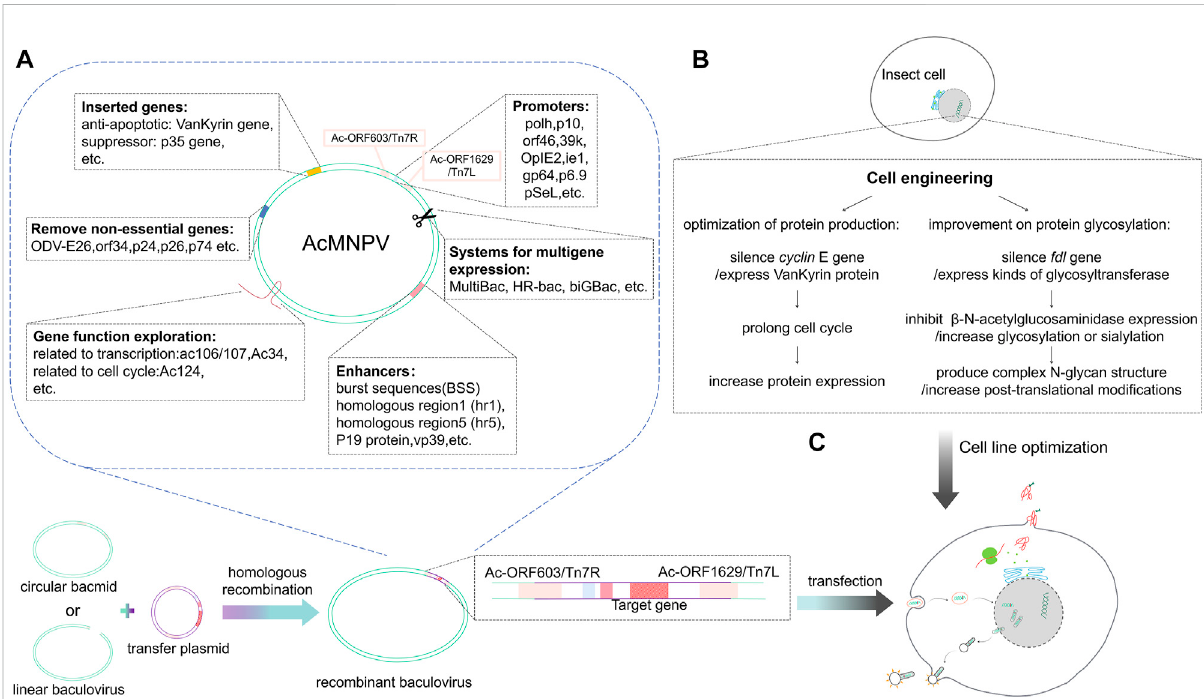
FIGURE 1 Baculovirus genome editing and the expression of foreign proteins. (A) The circular bacmid or linear baculovirus recombines with the transfer plasmid carrying the foreign gene through the T7 transposon or homology arm to form a recombinant baculovirus. The baculovirus is optimized at the molecular level, removing non-essential genes and inserting elements that are conducive to protein expression. After exploring gene functions of baculoviruses, ef fi cient promoters and enhancers are selected to design transfer vectors that can carry foreign genes. (B) Insect cell line optimization mainly includes optimization of exogenous protein glycosylation and production. (C) The recombinant baculovirus infects insect cells; after entering the cells, the foreign protein is expressed under the transcriptional regulation of the insect